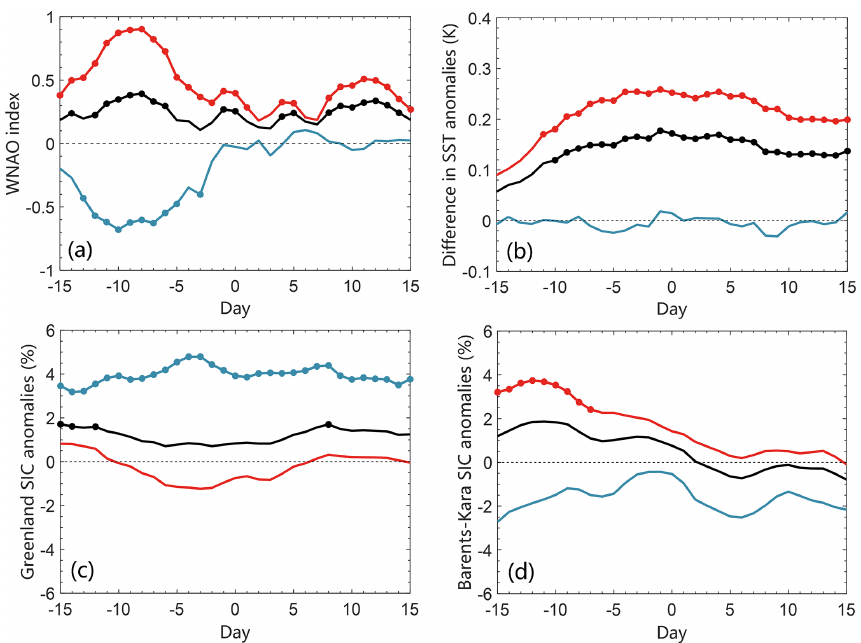
Figure 10. Composite daily time series of the (a) WNAO index, (b) difference in the SST anomalies over the two regions, as presented in Fig. 9a, (c,d) region-averaged SIC anomalies in the (c) Greenland Sea (marked by C in Fig. 9b) and (d) Barents Sea–Kara Sea (marked by D in Fig. 9b) for the 65 persistent haze events (black), 43 WNAO + -related persistent haze events (red) and 22 WNAO − -related persistent haze events (blue) from Day − 15 to Day 10. The difference in the SST anomalies is calculated by subtracting the region-averaged SST anomalies in the north (rectangle A) from the region-averaged SST anomalies in the south (rectangle B) (that is, B minus A). A persistent haze event that is related to the WNAO + (WNAO − ) is selected when its averaged WNAO index is positive (negative) from Day − 10 to Day − 6 of the persistent haze